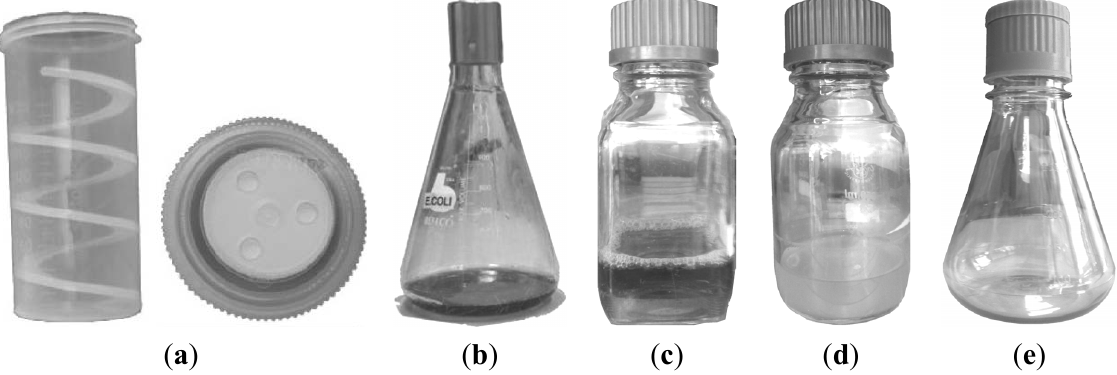
Figure 1. Images of culture containers used in this study; ( a ) a 250-mL helical track (HT) tube (left) and its vented cap (right); ( b ) a 1-L Erlenmeyer flask with a stainless steel closure; ( c ) a 250-mL square-shaped bottle; ( d ) a cylindrical glass bottle; ( e ) a 250-mL flat-base Erlenmeyer flask with a vented